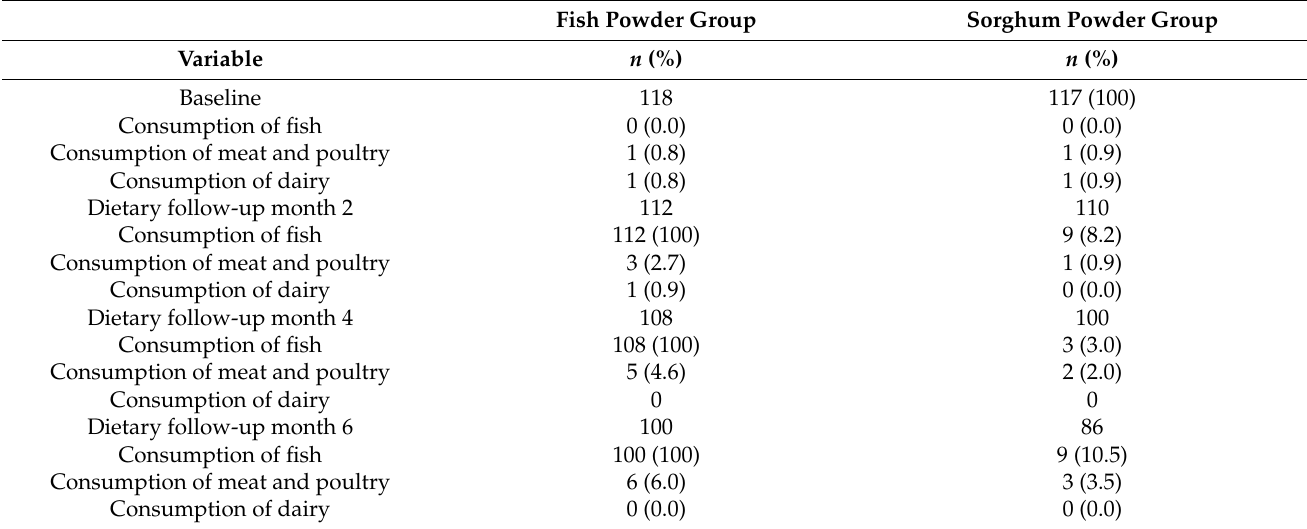
Table 9. Animal source food consumption by intervention